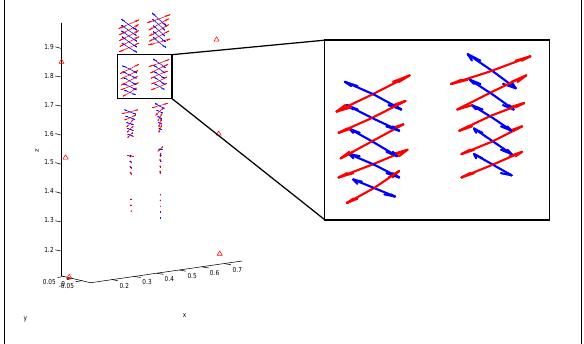
exist from the same target.